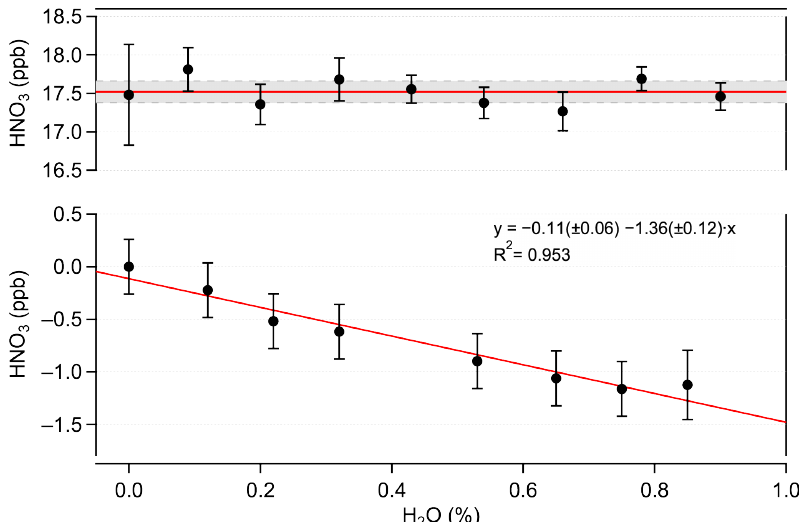
Figure 7. Top : offset-corrected HNO The solid red line represents the mean value. The dashed lines indicate the standard deviation ( ± 1 σ ). Bottom : influence of humidity on the HNO